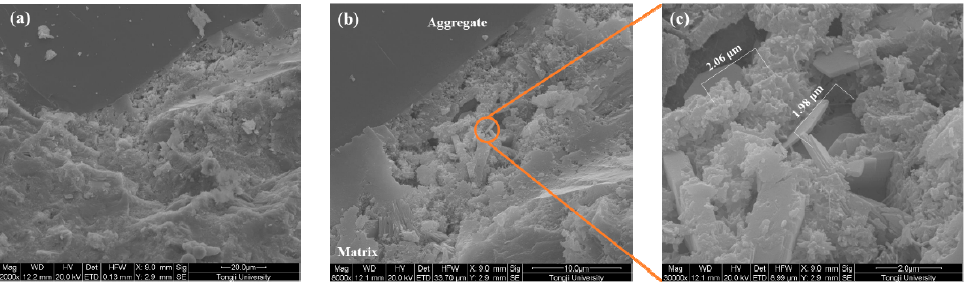
Figure 8. Microstructure of the interfacial transition zone (ITZ) of the control sample. ( a ) 2000×; ( b ) 8000×; ( c ) 30000×.